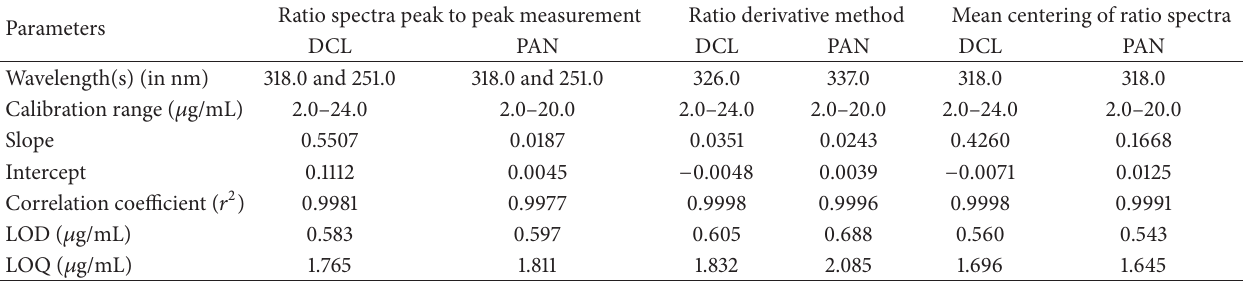
Table 1: Regression parameters obtained for the determination of diclofenac (DCL) and pantoprazole (PAN) using the proposed methods. Ratio spectra peak to peak measurement Parameters